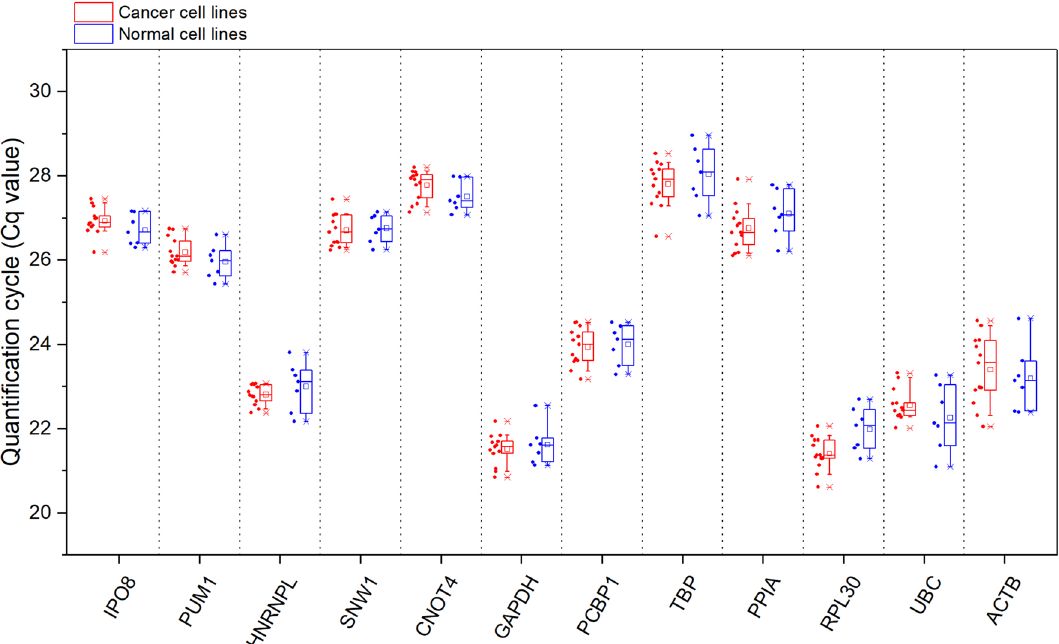
Figure 2. Cq values of twelve candidate reference genes in human cancer (red) and normal (blue) cell lines. Each dot represents the average Cq value of three biological replicates for each cell line. Candidate reference genes are arranged according to the comprehensive ranking in a decreasing order of expression stability. The boxes represent the data between the 25th and 75th percentile, while whiskers show the data range from the 10th to the 90th percentile. The minimum and maximum values are depicted as ‘x’. The average values are represented as squares and the median values are illustrated as lines. This graph was created with OriginPro 2018 (OriginLab